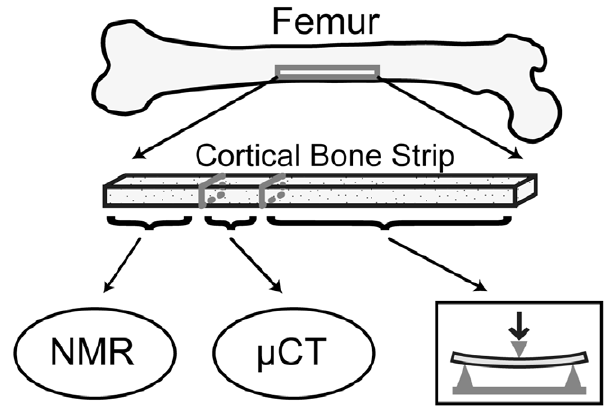
Figure 4. From each cadaveric bone studied, one strip of cortical bone was extracted, three separate pieces of which were used for NMR, m CT, and mechanical testing.